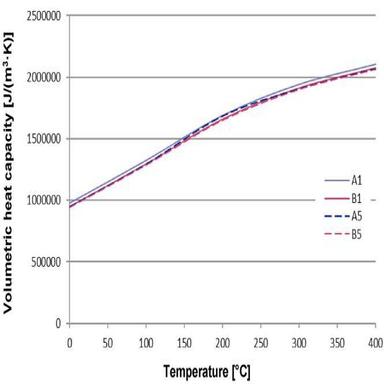
Estimated heat capacity as function of temperature of base coated (A1, B1) and nano-coated (A5, B5) ceramic material.